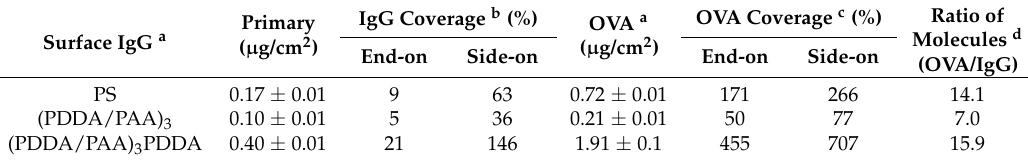
Table 1. Results of the primary antibody and OVA